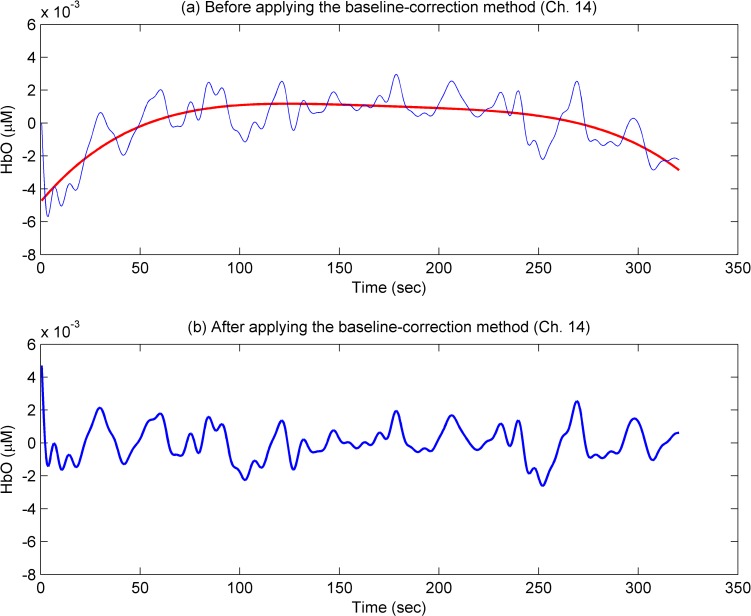
Illustration of the baseline-correction method (Ch. 14, Subject 5).(a) An HbO signal before applying the baseline-correction method (blue thin curve) and the fitted signal f(x) (red thick curve); (b) the corrected HbO signal (blue thick curve).